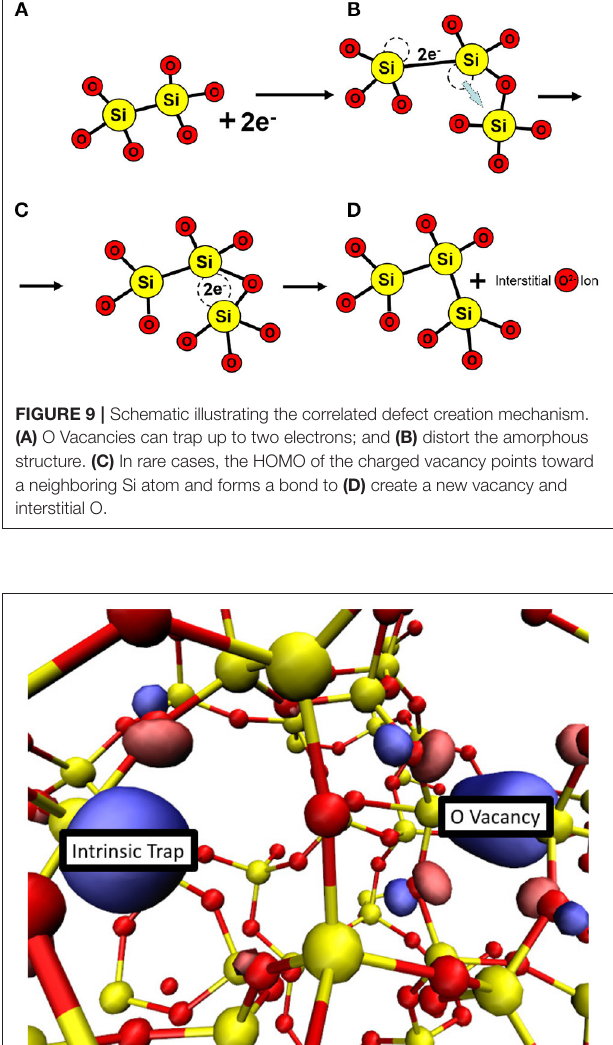
creating another vacancy nearby increases as well. Di-vacancies have a 50% chance, and tri-vacancies are the most likely to